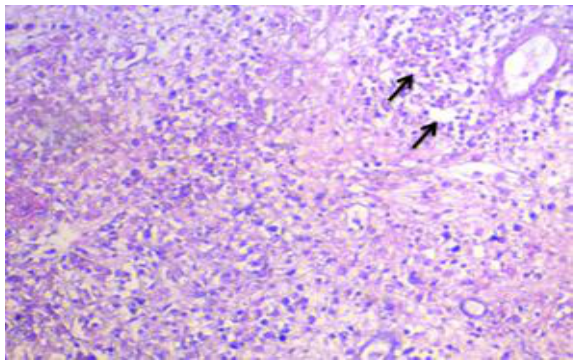
Figure, 8: Chicken spleen shows focal vacuolation and damage of lymphocytes in the cortical zones and in germinal centres (black arrows) (H&E stain).